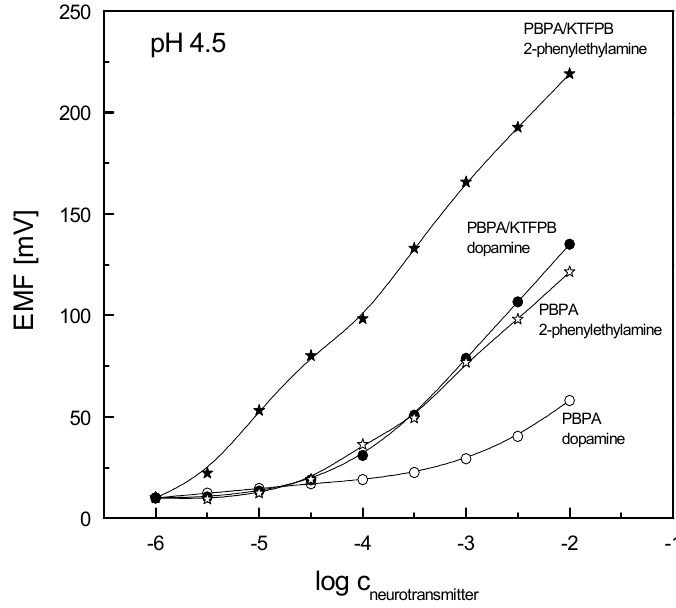
Figure 3. Potentiometric responses of ion-selective electrodes formulated with PBPA receptor (PVC/DOS, with and without KTFPB) towards dopamine and 2-phenylethylamine.